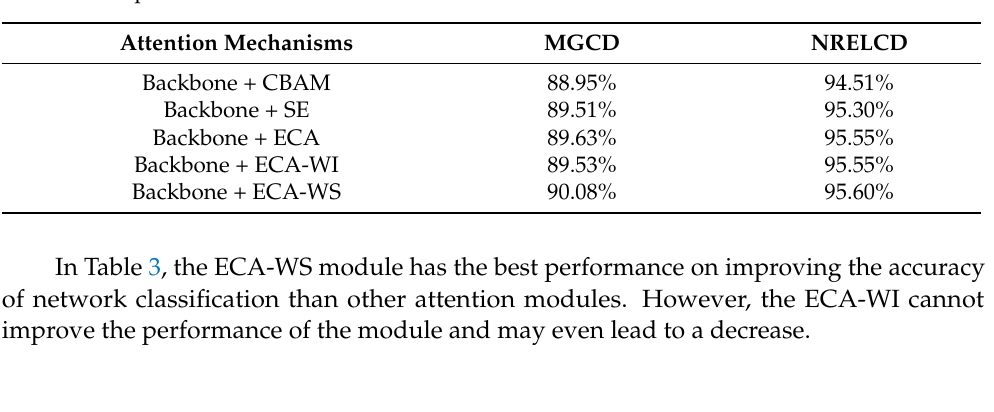
Table 3. Comparative result of attention